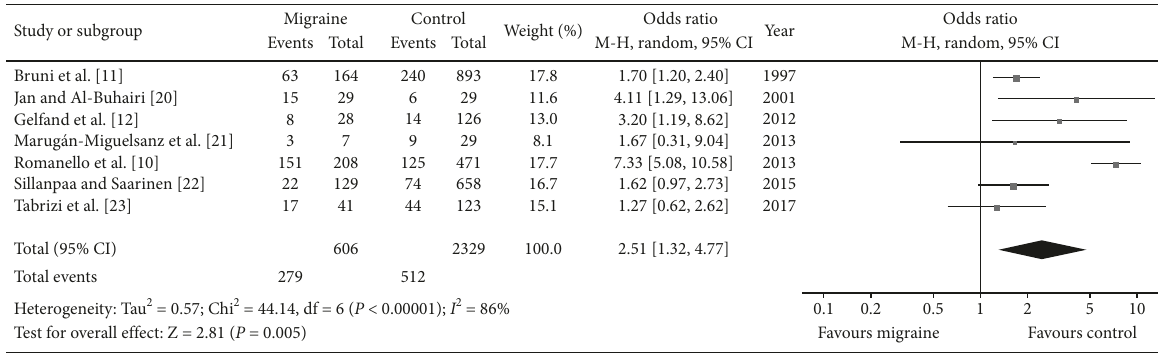
Figure 2: Forest plot of the incidence of infant colic between migraineurs and controls.